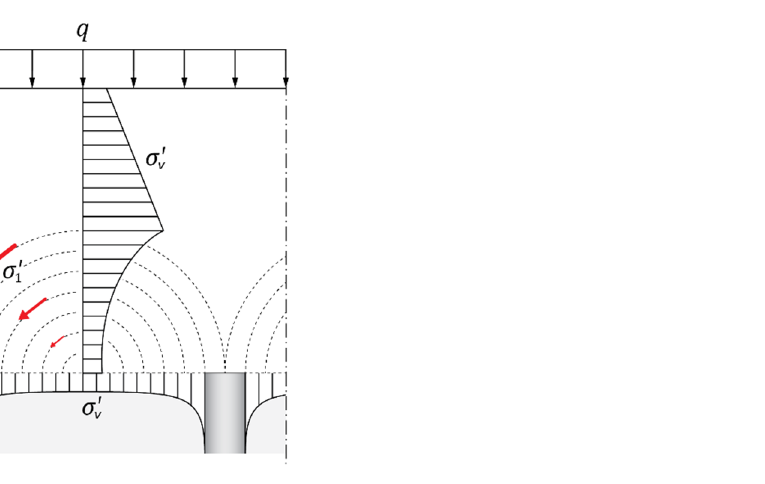
Figure 5. Illustration of the vertical stress reduction due to arching, based on Zaeske [31], and the major principal effective stress ( σ (cid:48) ) vectors. Arch shape according to the Concentric Arches model 1 [8].